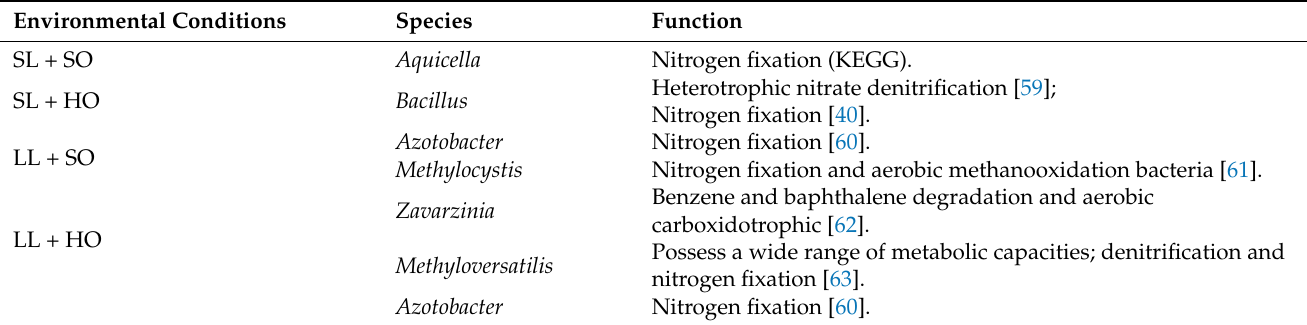
Table 3. Significantly down-regulated species after PGPR inoculation in the four environmental conditions and their ecological